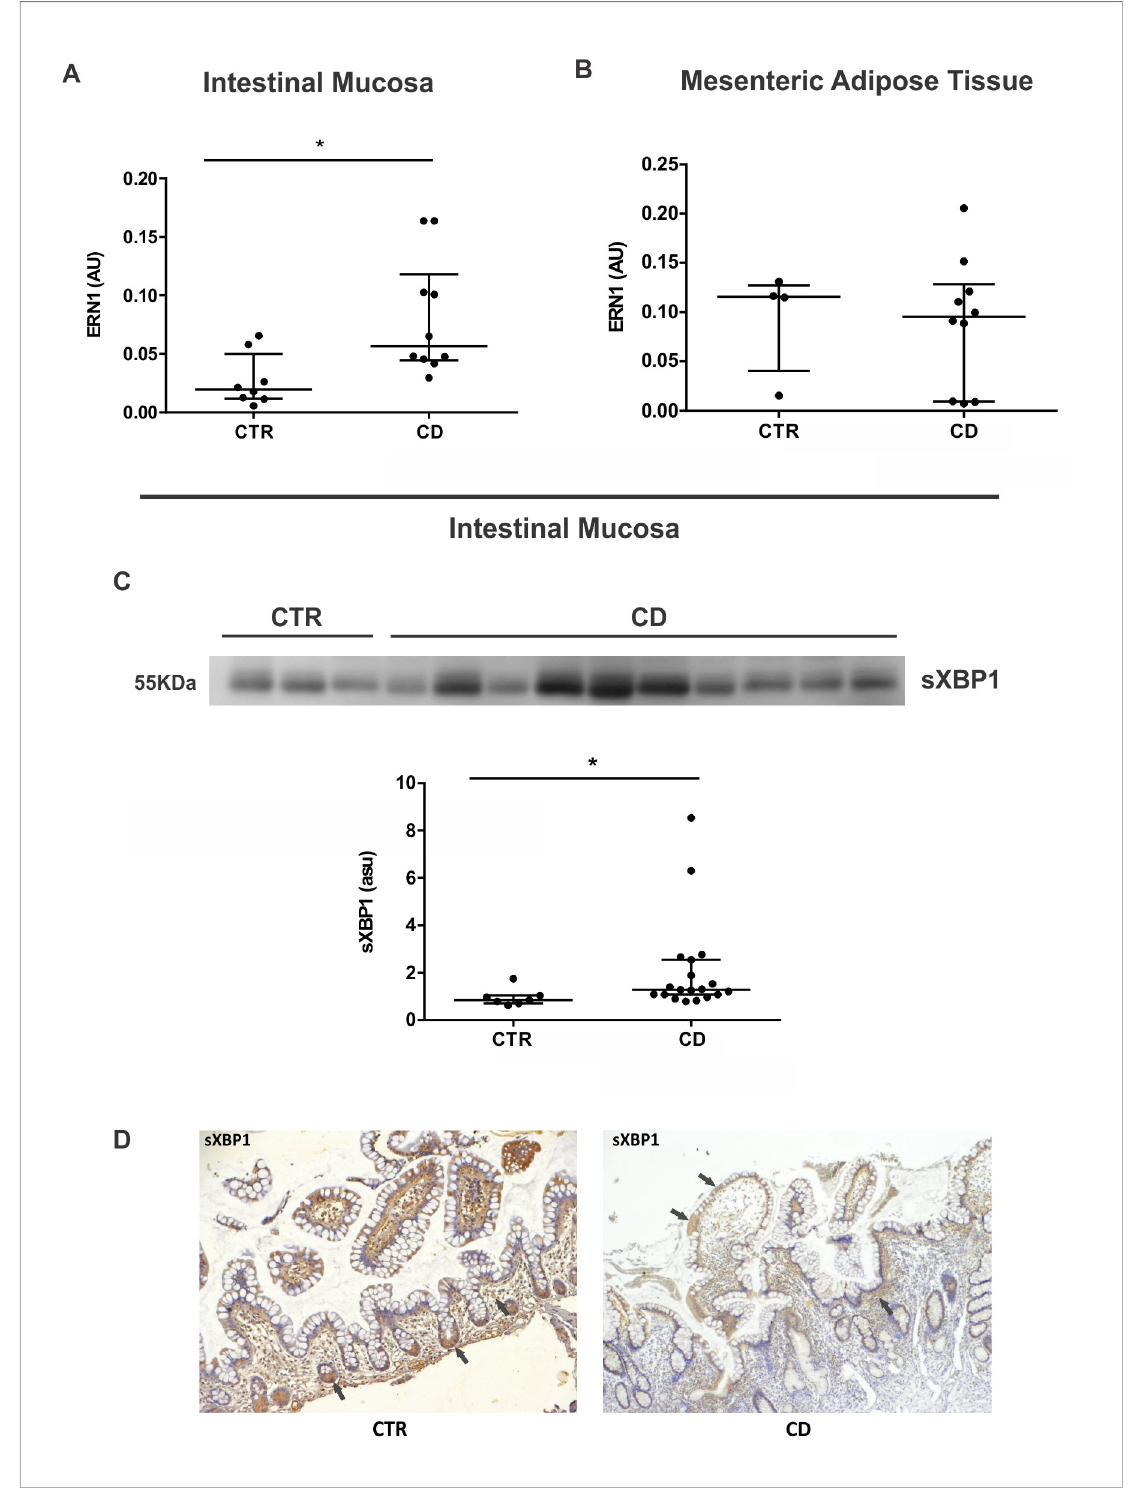
Fig 1. Activation of IRE1/sXBP1 pathway in the intestinal mucosa and in the mesenteric adipose tissue (MAT) of Crohn’s disease patients. mRNA levels (qRT-PCR) of ERN1 gene was investigated in the intestinal mucosa (A) and in MAT (B) of CD patients (CD group) compared to control group (CTR group). � P < 0.05 and �� p < 0.01 are considered statistically significant versus control group. Western blot